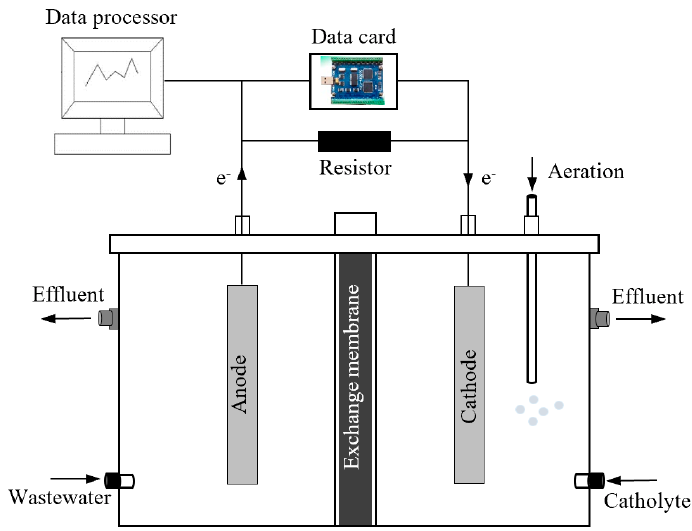
Figure 1. Schematic diagram of the MFC experiment system.